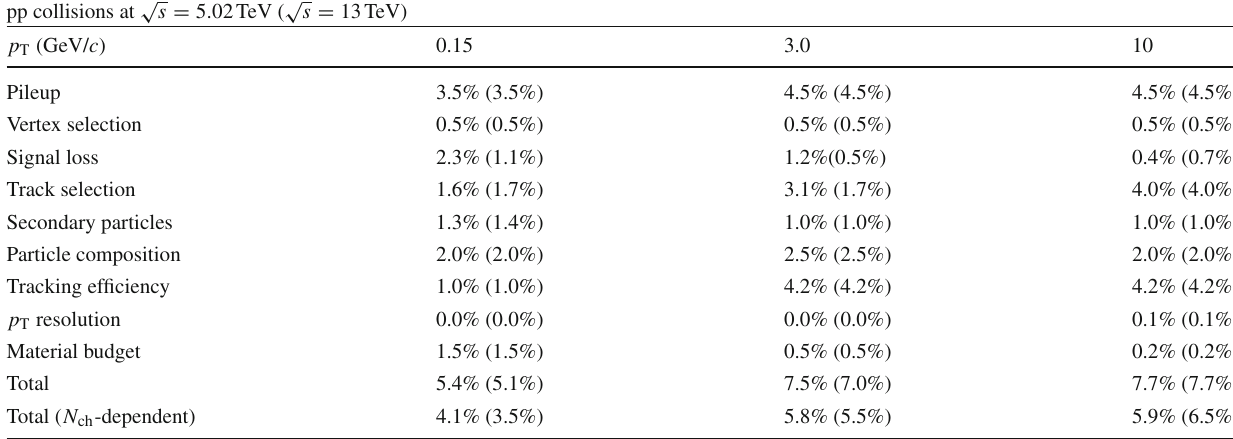
the parentheses. The systematic uncertainty due to trigger and event √ s = 5 . 02TeV. selection is p T independent and therefore it is not included in the table. It reaches ∼ 7 . 6% ( ∼ 6 . 3%) for the lowest multiplicity class in pp col- √ √ s = 5 . 02TeV ( s = 13TeV), and it is smaller than 0.5% lisions at √ s = 13TeV are shown inside